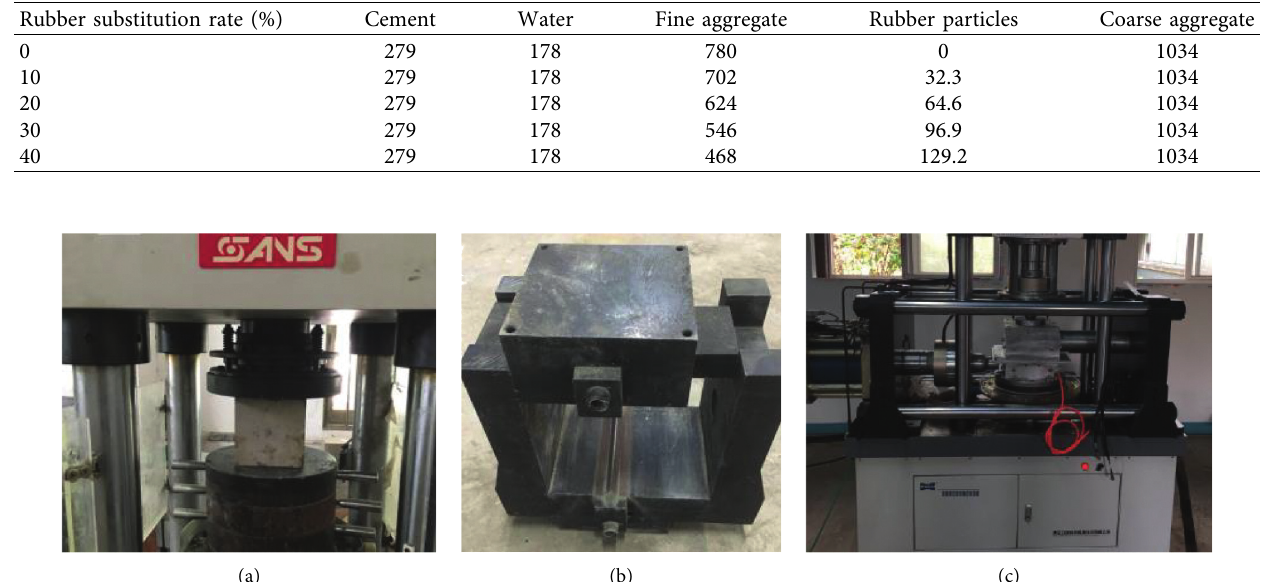
Figure 2: Concrete experiment equipment. (a) Schematic diagram of compression, (b) splitting device, and (c) direct shear apparatus.